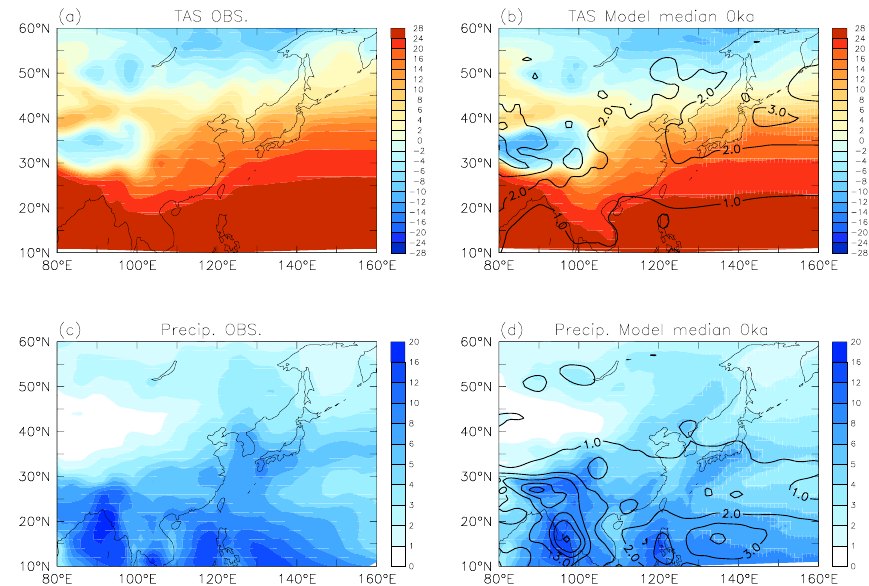
Fig. 1. (a) Observed annual mean surface air temperature (TAS, ◦ C) merged from CRU data on land and NCEP reanalysis over the ocean; (b) same as (a) but for the PMIP3 model median; (c) observed summer precipitation (JJA, mmd − 1 ) from CMAP data; and (d) same as (c) but for the PMIP3 model median. The contours in (b) and (d) denote the standard deviation of the 10 PMIP3 models for the TAS and precipitation,